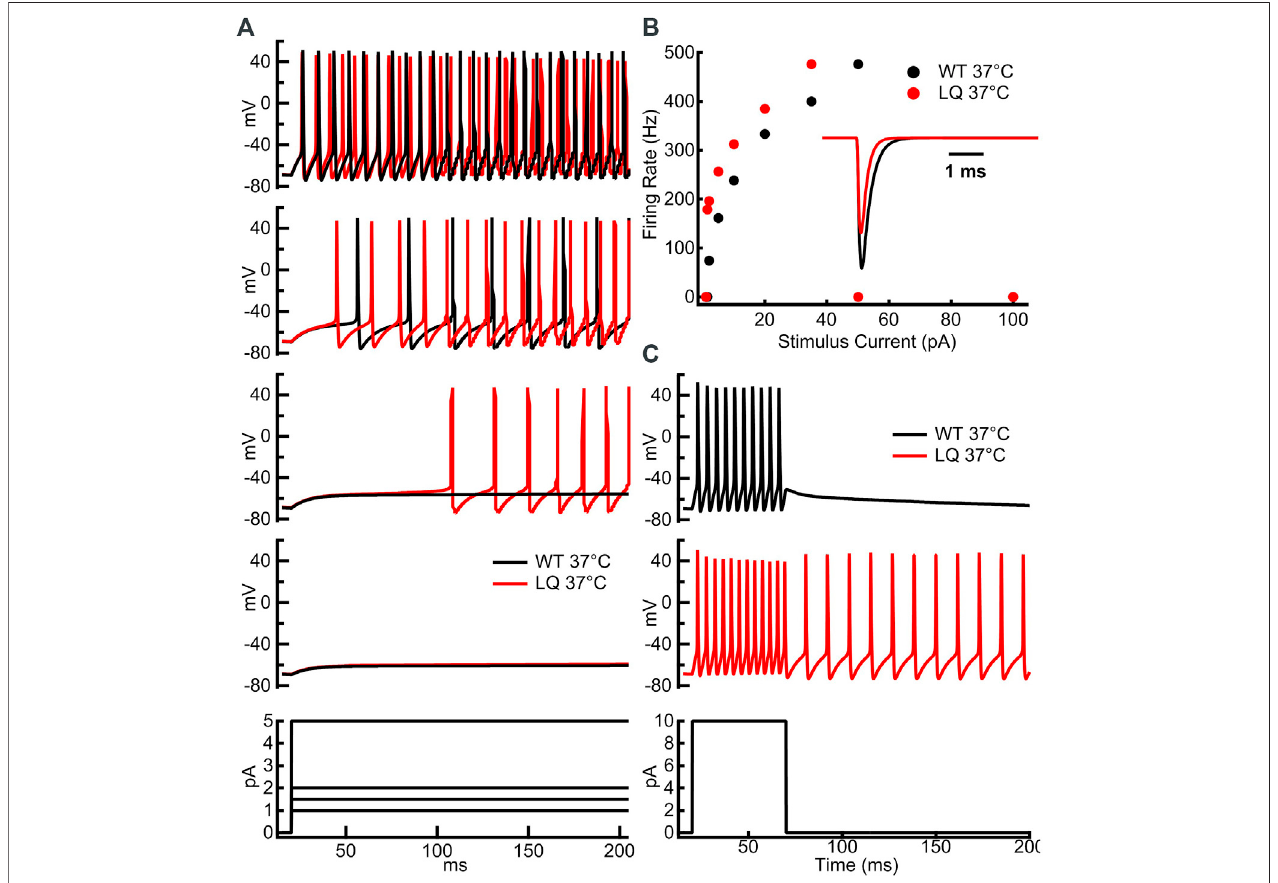
FIGURE5| L1624Qincreasesneuronalexcitabilityatlowerinputstimuli. (A) :Simulatedactionpotential fi ringinWT(black)andL1624Q(red)expressingneuronsat 37 ° C in response to stimulus currents (bottom) of 1 pA (second from bottom), 1.5 pA (middle) , 2 pA (second from top), or 5 pA (top) . (B) : Simulated action potential fi ring rates of WT and L1624Q expressing neurons in response to stimuli between 1 and 100 pA. (B) inset : Simulated WT (black) and L1624Q (red) sodium currents in response to a test pulse to 0 mV from a holding potential of − 120 mV. (C) : Simulated action potential fi ring of WT (black) and L1624Q (red) expressing neurons in response to a 10 pA stimulus for 50 ms followed by zero stimulus (bottom)